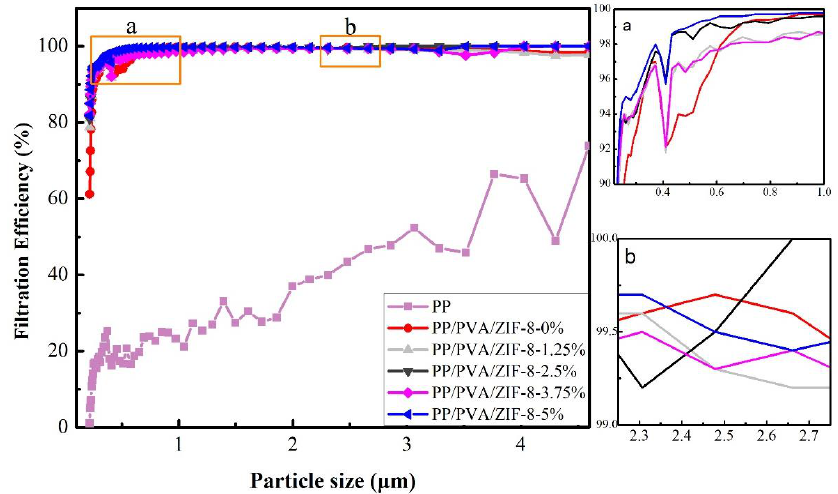
Figure 7. Filtration efficiency of PP melt-blown membranes and PP/PVA/ZIF-8 melt-blown electrospun composite membranes when diethylhexyl sebacate (DEHS) aerosol is 0.218-4.595 µ m. (a) and (b) represent Nanomaterials 2020 , 10 , x FOR PEER REVIEW 11 of 18 the enlarged part of the corresponding part in the figure.